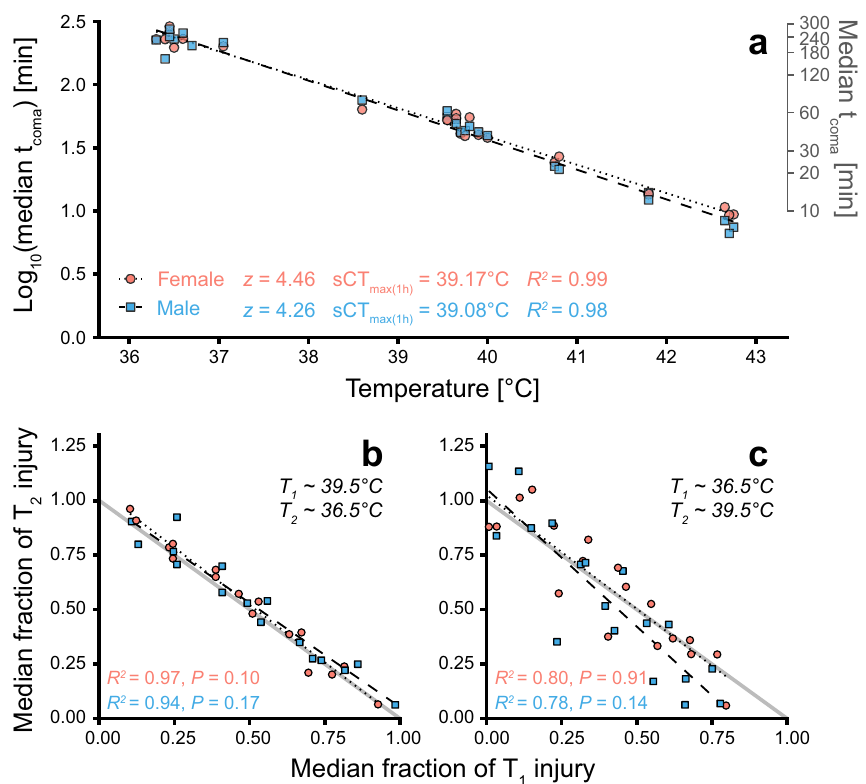
Figure 3. Thermal death time curves and test of injury additivity between two temperatures. ( A ) Flies were exposed to a static stressful temperature until coma onset (t coma ). Each point is the median t coma of a group (n = 2–10) and TDT curves are made for each sex by linear regressions of median log 10 (t coma ) vs. assay temperature. ( B ) Groups of flies (n = 5–6 per sex) were exposed to a high temperature (~ 39.5 °C) and then, after different durations, transferred to a lower temperature (~ 36.5 °C) where median t coma was recorded. The exposures are shown as fractions of injury resulting in coma at T 1 (x-axis) and T 2 (y-axis), where small and large fractions indicate brief and long exposures, respectively (i.e. brief exposure results in small accumulation of injury relative to the critical amount of injury). If injury acquired at two different temperatures is additive, the two fractions should sum to 1, i.e. follow the (full) line of additivity. ( C ) A similar experiment as ( B ), but with initial exposure to ~ 36.5 °C and the subsequent exposure to ~ 39.5